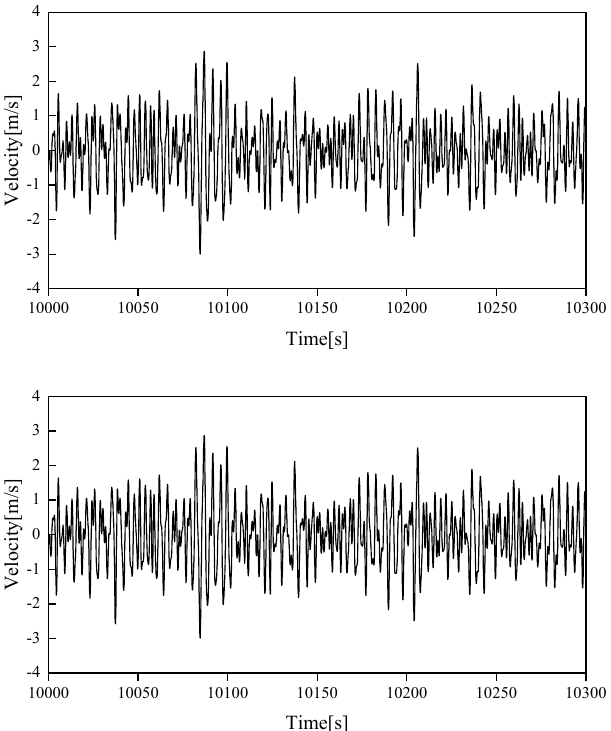
Figure 12. Three-hour Z-direction wave surface elevation velocity chronogram based on the JONSWAP spectrum.